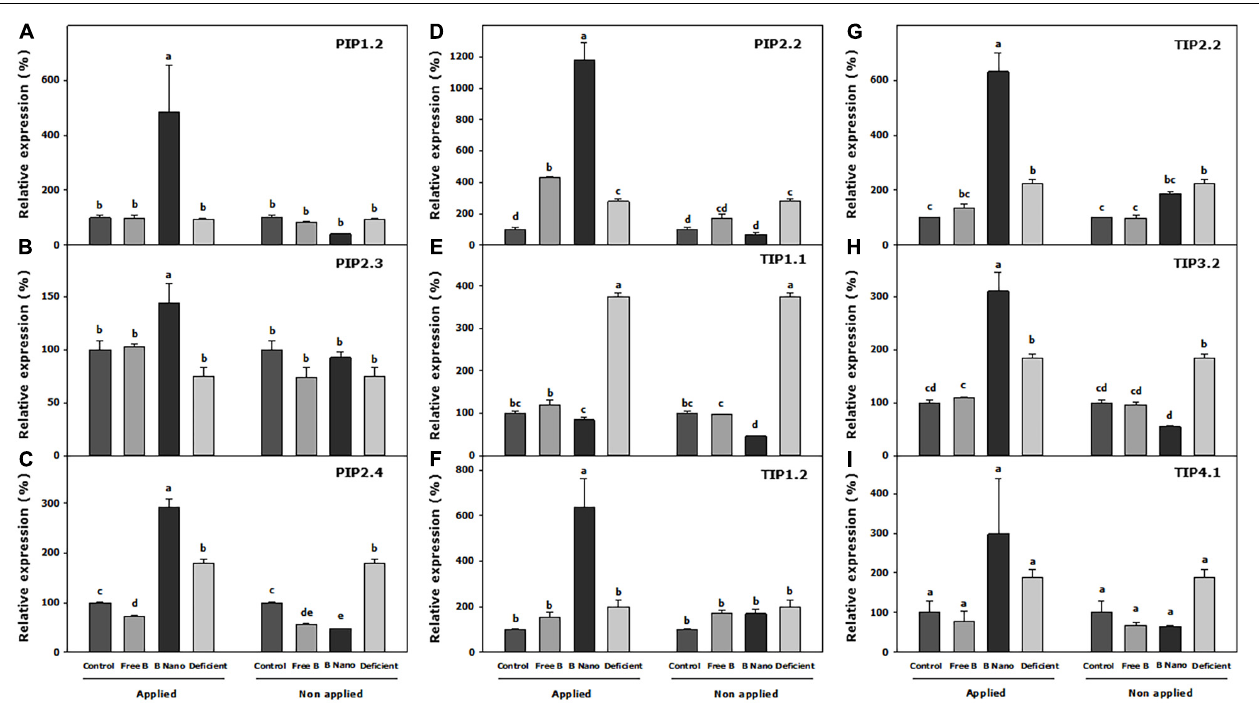
FIGURE 5 | Expression analysis of (A) PIP1.2, (B) PIP2.3, (C) PIP2.4, (D) PIP2.2, (E) TIP1.1, (F) TIP1.2, (G) TIP2.2, (H) TIP3.2, and (I) TIP4.1 Prunus dulcis aquaporins (AQPs) at S0. Statistical analysis was performed including all B-applied and non-B-applied leaves, separating each AQP. Normalized expression levels were rescaled and presented as a relative expression (r.e.) with respect to the control. B Nano, Nanoencapsulated B. The values are the means ± SE of four individual analyses. Columns with different letters differ significantly according to Duncan’s test ( p =